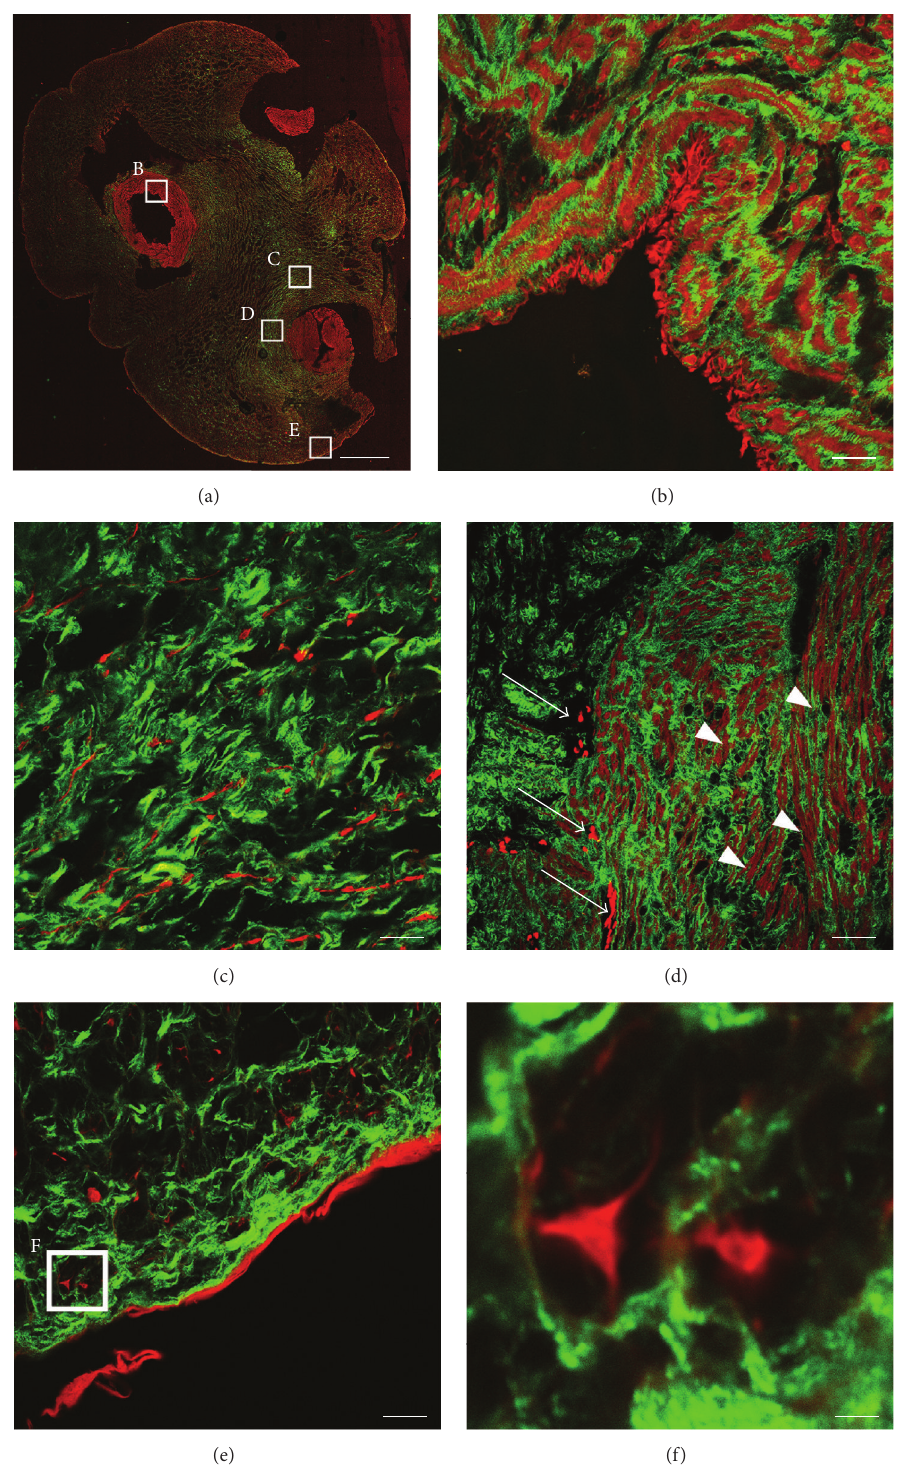
Figure 1: Label-free imaging of umbilical cord tissue compartments. (a) Image composition derived from multiple fields of view for AF (red) and SHG (green) in unstained cord tissue, scale bar = 1mm. (B–E) Detailed image sections of (a), scale bars = 20 𝜇 m. (b) Lamina intima and media of the umbilical vein. (c) Wharton’s jelly and perivascular zone of an umbilical artery. (d) Umbilical artery media and adventitia showing intensely fluorescent cells (arrows) and less bright smooth muscle cell bodies (arrowheads). (e) Subamnion and amniotic epithelial layer. (F) Detailed image of (e) displaying tripolar cells within the subamniotic zone, scale bar = 2 𝜇 m. Representative images from 3 independent donors are